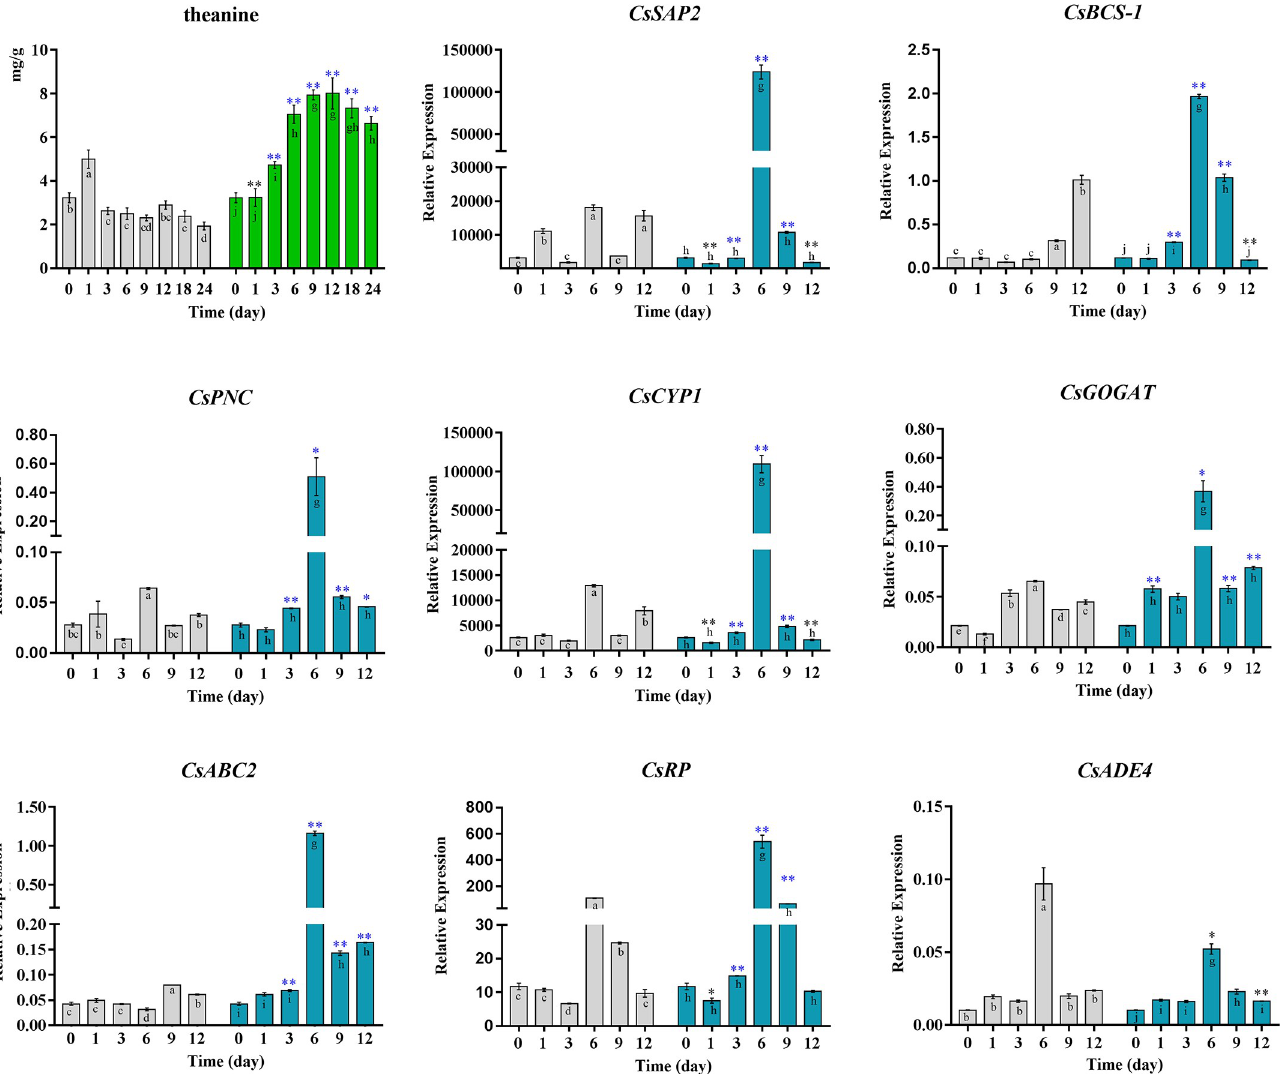
Fig 3. HPLC and qRT-PCR analysis of thea content and gene expression. The abscissa indicated samples collected at 0-day, 1-day,3-day, 6-day, 9-day, 12-day, 18-day and 24-day. The grey bar and colored (green, blue) bar represented the changes of thea content or gene expression in the control and EA treatment, respectively. Significant differences comparing the control and EA treatment at each time point using one-way ANOVA and a Fisher’s LSD test ( � p -value < 0.05, �� p -value < 0.01). The black asterisk and blue asterisk denoted a significant drop and increase, respectively. Different letters indicated statistical significance among time points for the control (a, b, c, d, e, f) and EA treatment(g, h, i, j). GraphPad Prism was used to draw the plot, and SPSS was used to conduct statistical analysis.